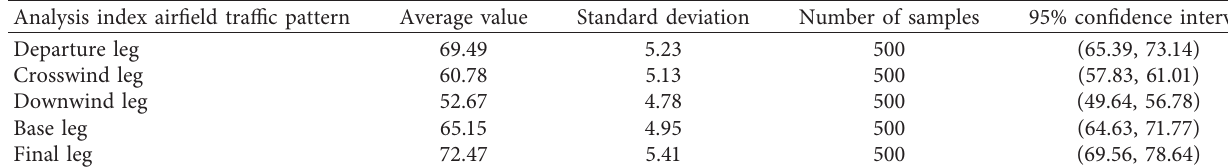
Table 1: Statistical analysis results of total scores of NASA-TLX scales.